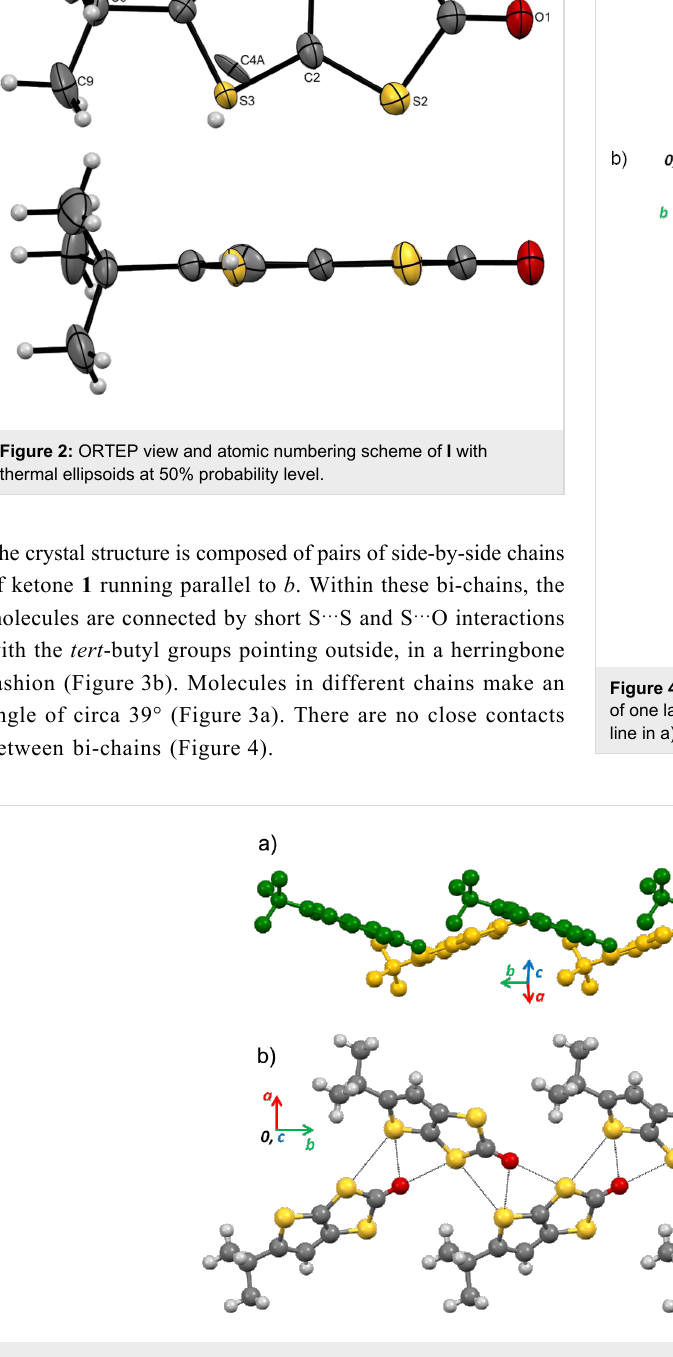
Figure 3: Molecular herringbone bi-chains in the crystal structure of I : a) view along the molecular planes and perpendicularly to the chain axis b , with molecules in different chains colored differently and b) view along c . The short contacts are represented as black dotted lines.